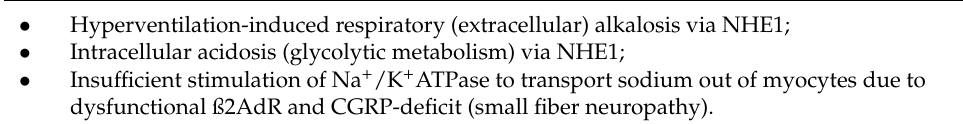
Table 1. Mechanisms of sodium loading in skeletal